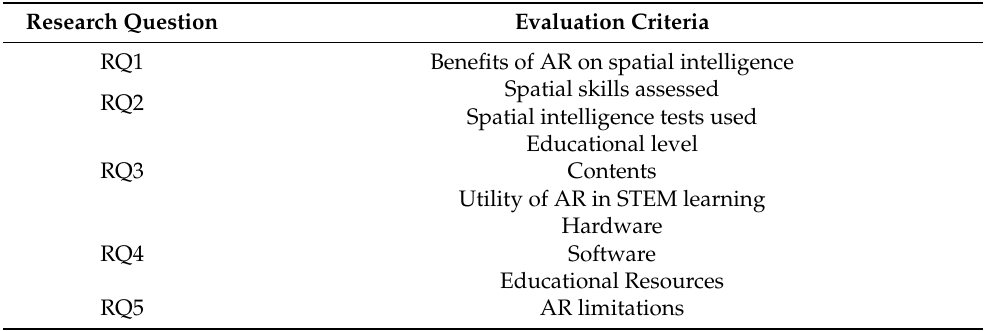
Table 2. Evaluation criteria related to the research questions.